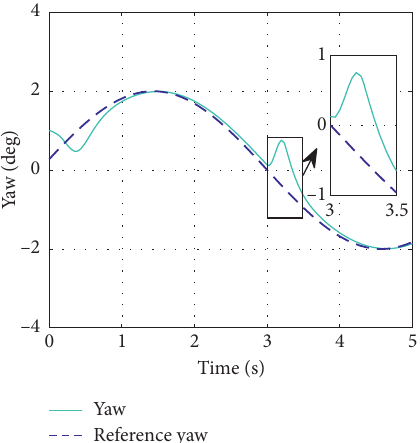
Figure 5: The tracking control result of yaw angle of the aerial tree-pruning robot.